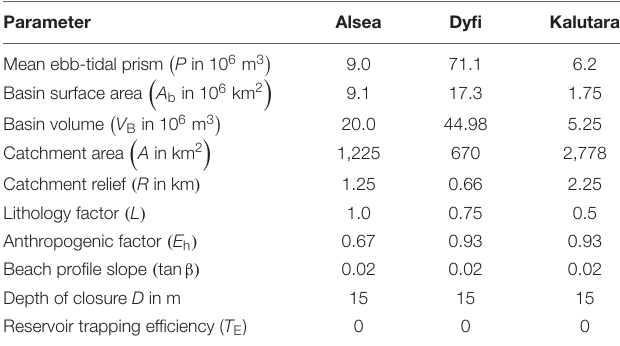
TABLE 1 | Properties of the selected case study CEC systems [after Bamunawala et al. (2020)]. Parameter Alsea Dyfi Kalutara